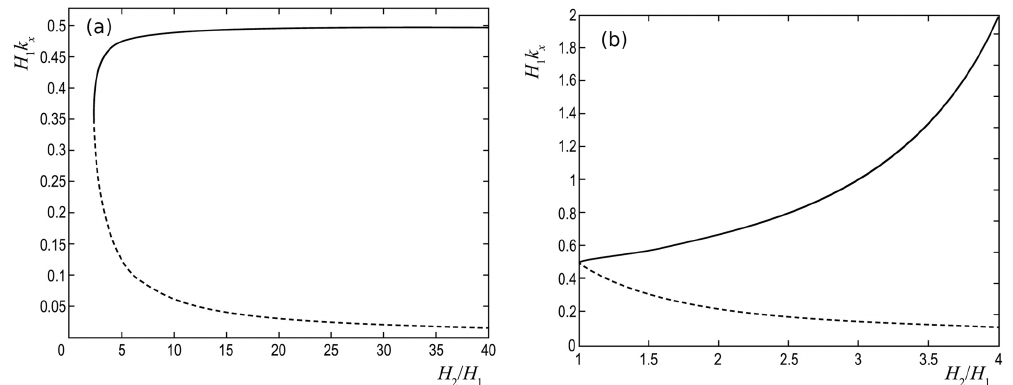
Figure 4. Horizontal scales k x H 1 , on which the modes with the dispersions ω 2 = k x g (a) and ω 2 = k x g(γ − 1 ) (b) are realized, depending on d = H 2 /H 1 . (See text for